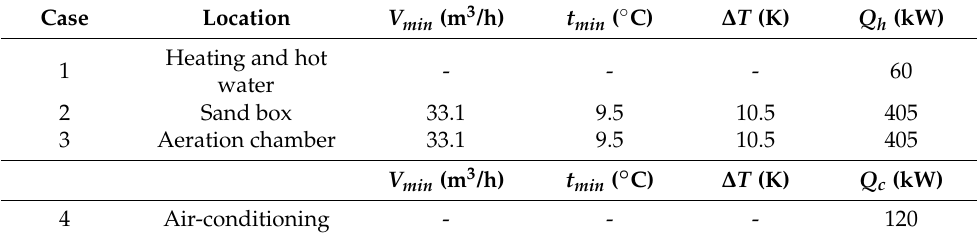
Table 5. The required heating and cooling capacity at different locations at the treatment